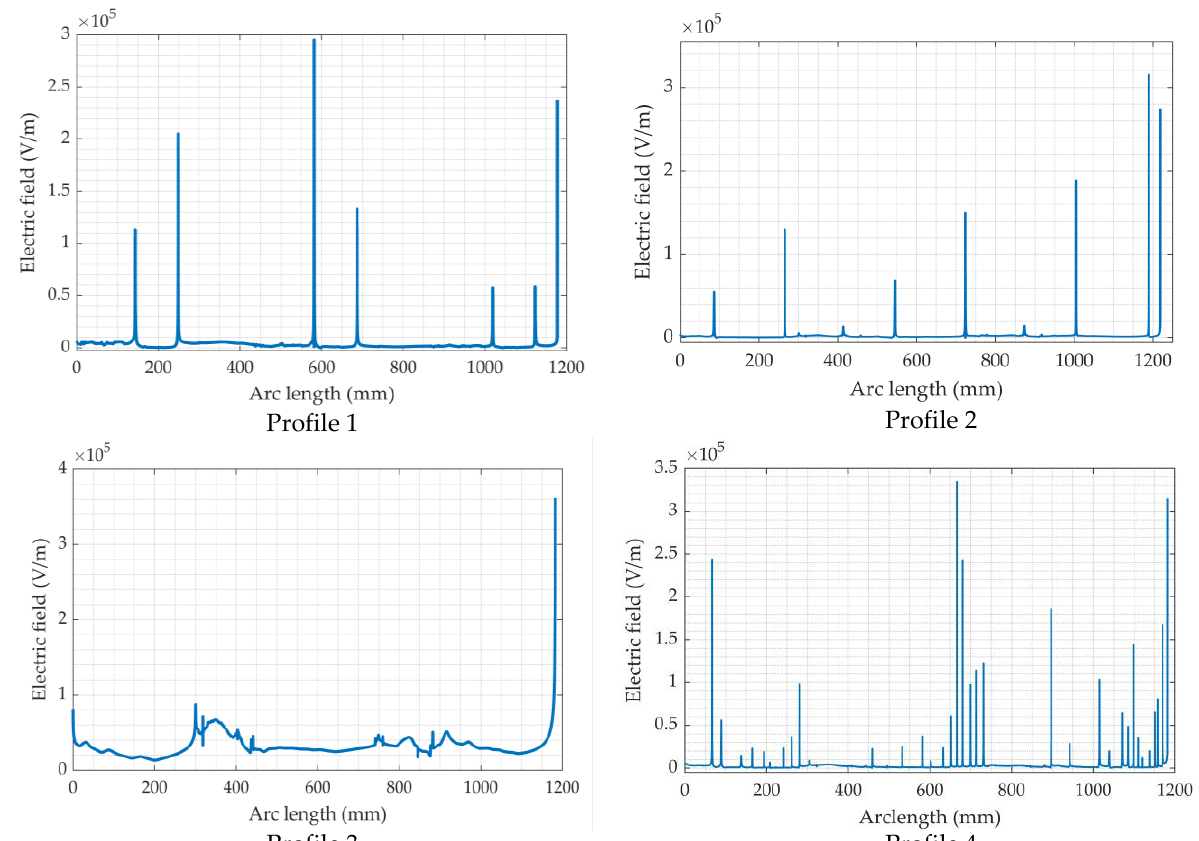
Figure 15. Electric field distribution on insulators under different RTV coating damage profiles.